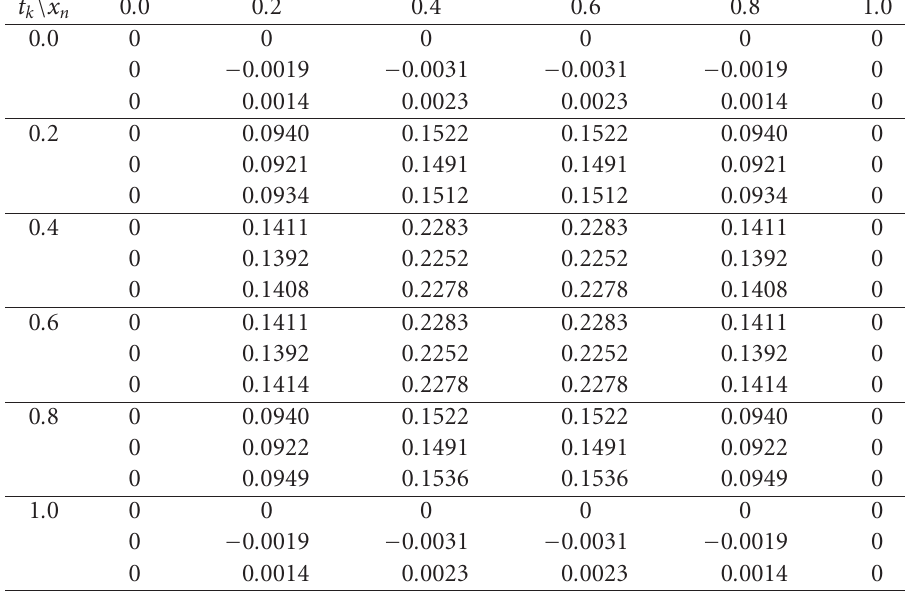
Table 4.1. The first line is the exact solution, the second line is the solution of Rothe’s di ff erence scheme, and the third line is the solution of the second-order accuracy di ff erence scheme. t x k \